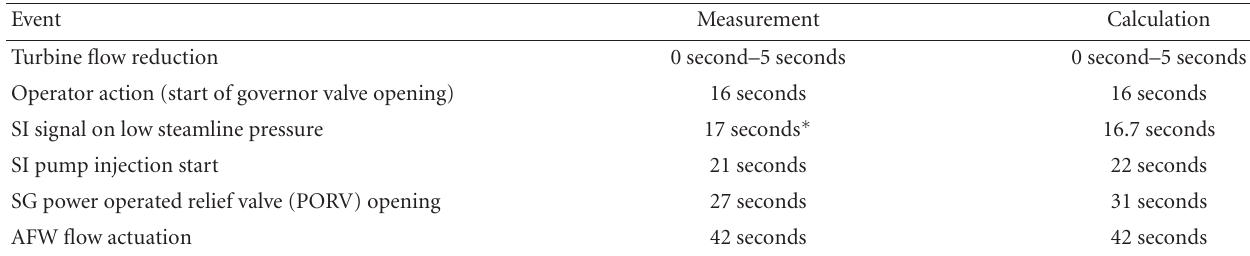
Table 3: Time sequence of main events during